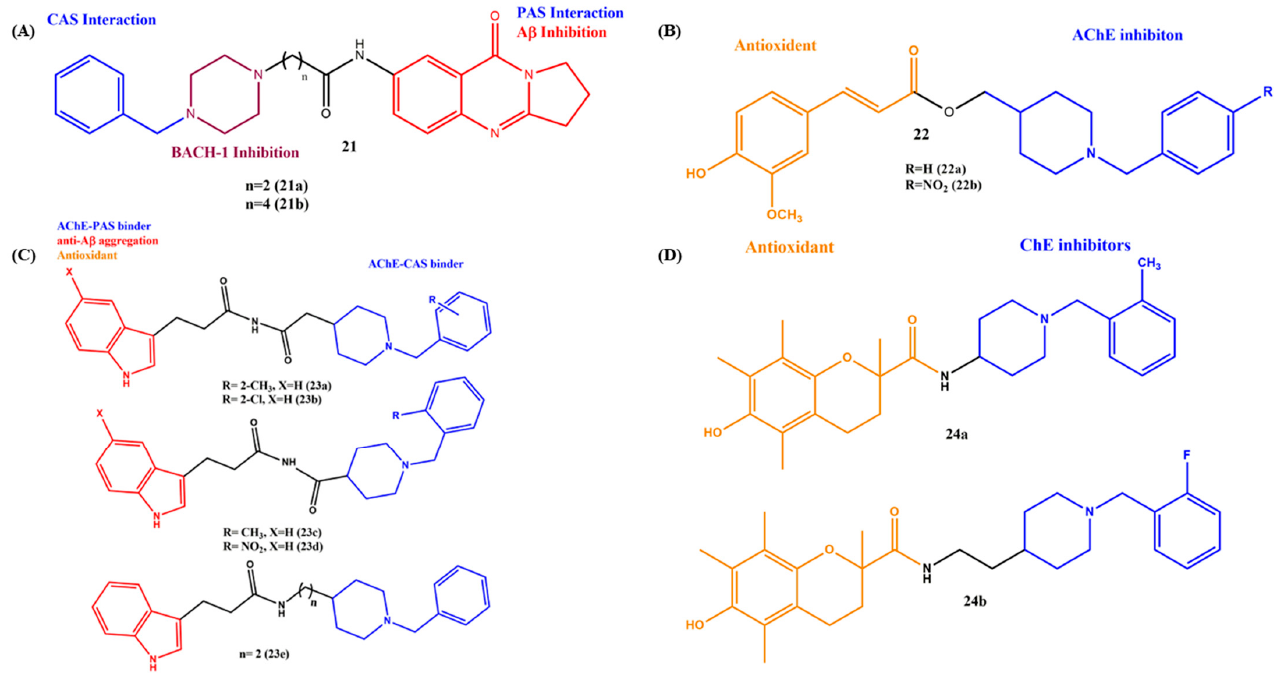
Figure 9. ( A − D ) Chemical structures of donepezil-derived MTDLs for